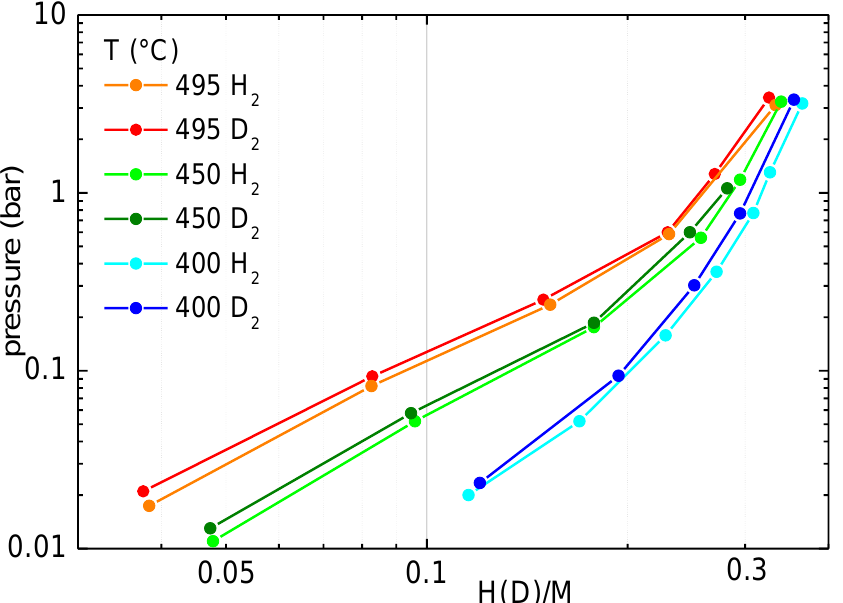
Figure 2. Pressure-composition isotherms in double logarithmic scale for hydrogen or deuterium absorption in Ni 33 Ti 39 Nb 28 at selected temperatures.